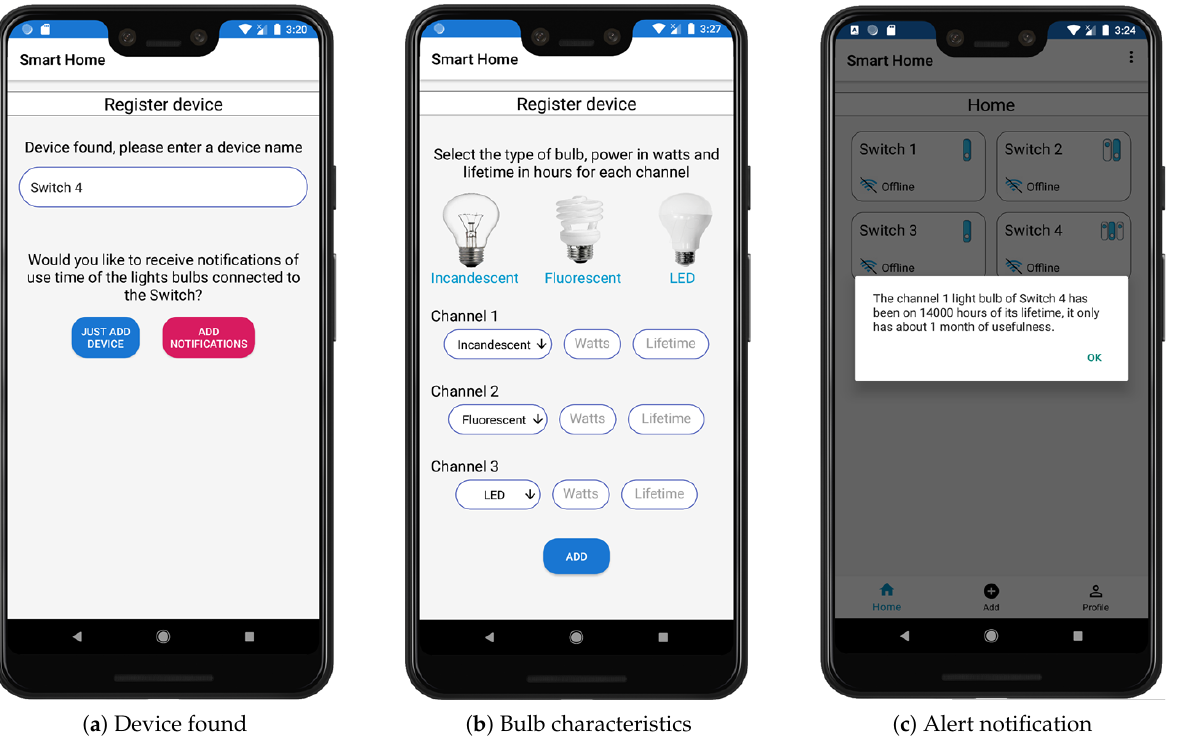
Figure 7. Add device to Android